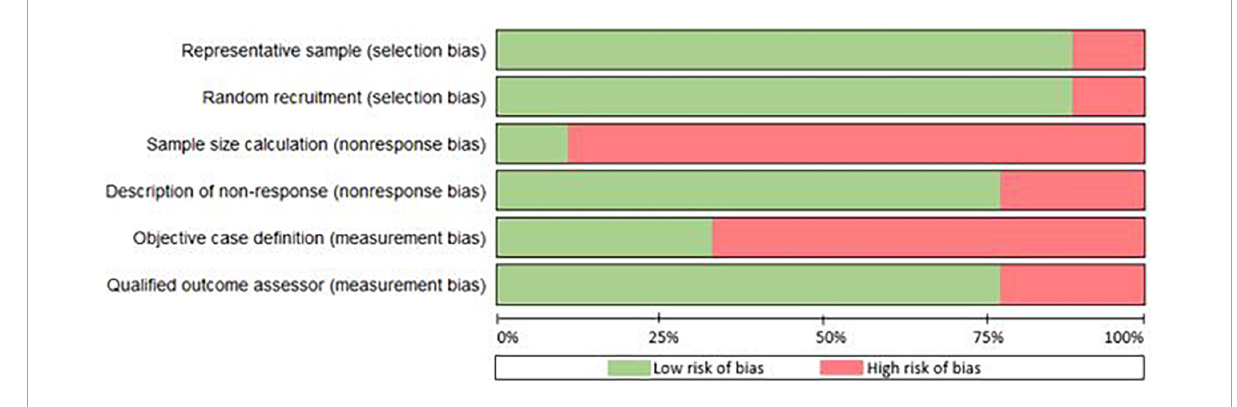
FIGURE3 Risk of bias as percentages across the nine included studied in this